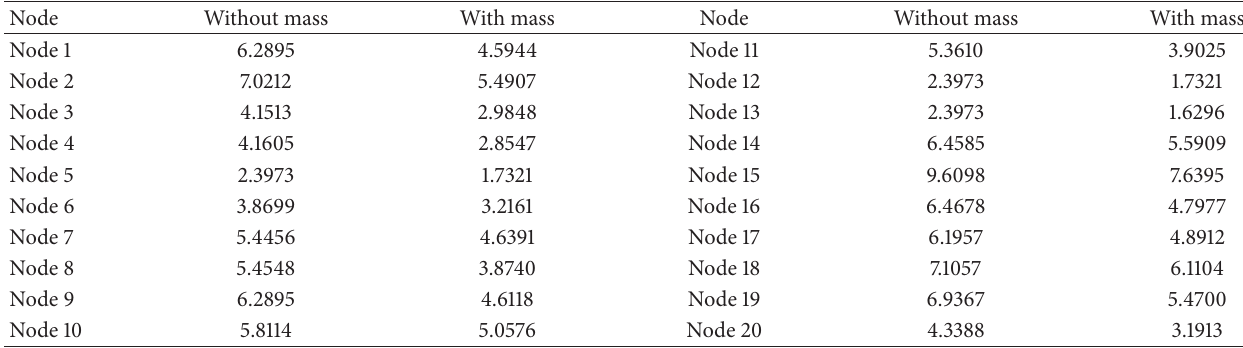
Table 4: The topology potential of Dolphin nodes with two schemes.